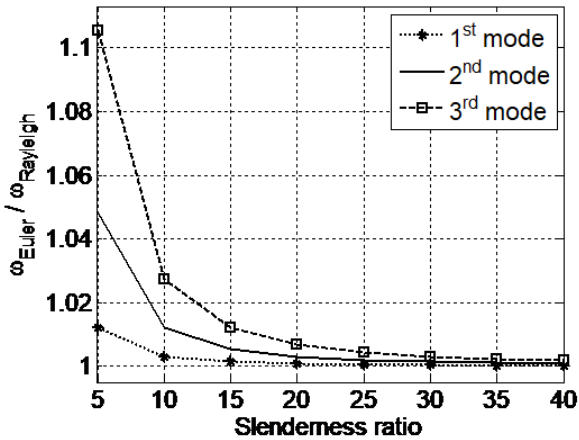
Figure 2: Variation of the classical frequency ratio against to slen- derness ratio and mode numbers